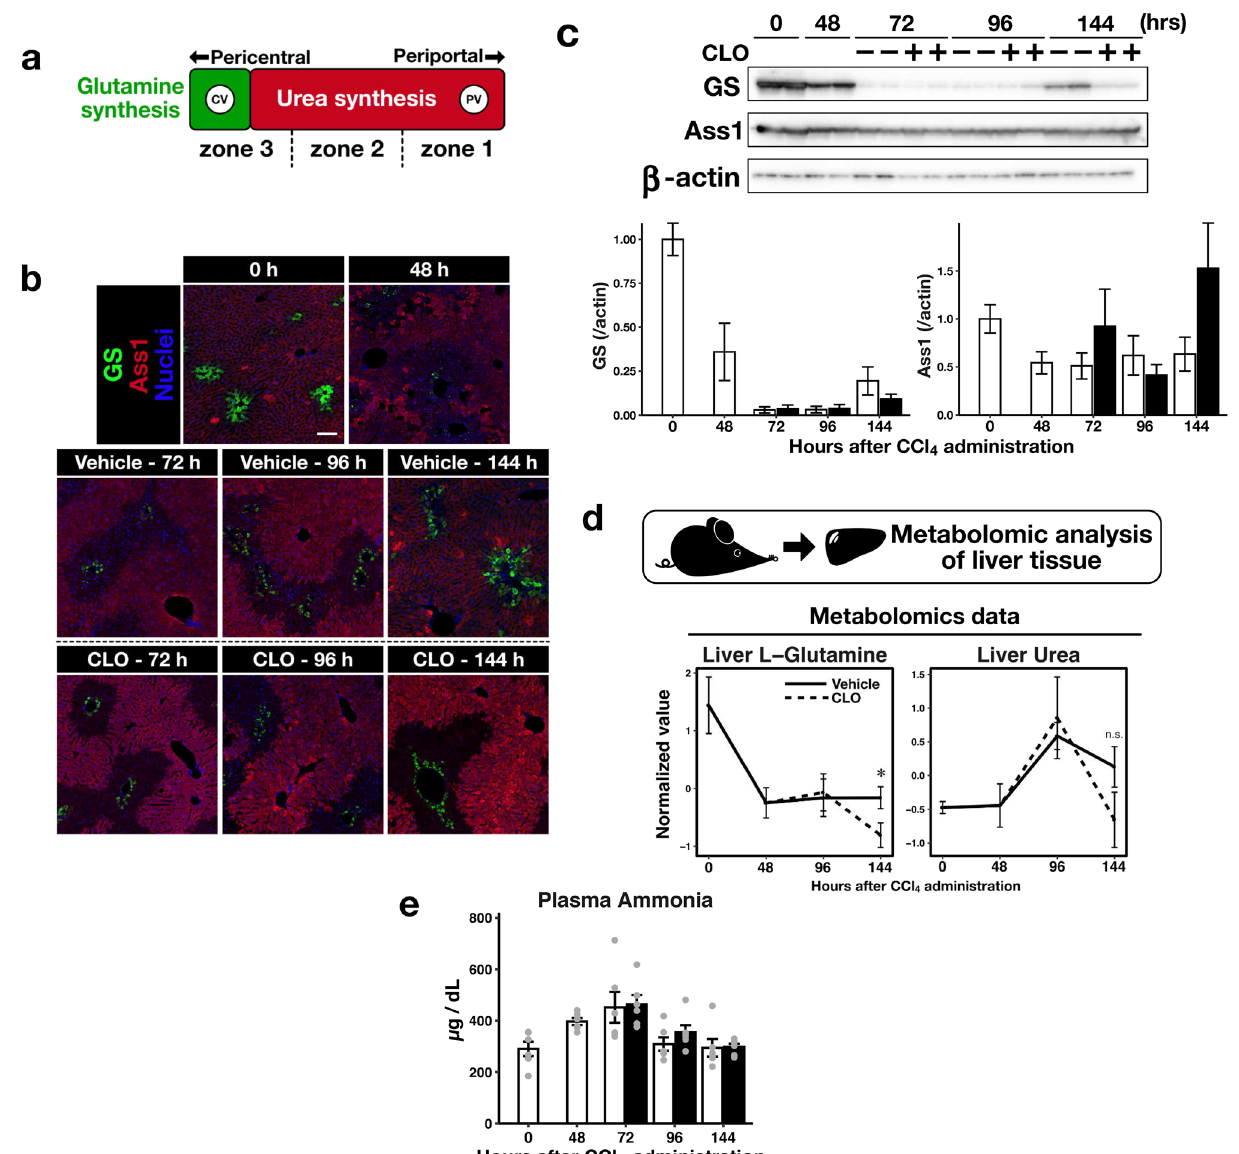
Figure 3. Effects of tissue remodelling suppression on glutamine and urea synthesis during regeneration. ( a ) Zonation patterns of glutamine and urea synthesis in liver lobules. Glutamine was synthesised by hepatocytes surrounding the central veins. Urea was synthesised by all hepatocytes except those surrounding the central vein. CV central vein; PV portal vein. ( b ) Representative immunofluorescence staining images of glutamine synthetase (GS) and argininosuccinate synthase 1 (Ass1) (scale bar, 100 µm); green, GS; red, Ass1; blue, cell nuclei. ( c ) GS and Ass1 protein expression levels measured by immunoblotting. β-actin was used as the loading control. ( d ) Liver glutamine and urea levels revealed by metabolomic analysis. ( e ) Plasma ammonia levels. Data are presented as mean ± SEM (n = 6/group). The vehicle and CLO groups were compared at each time point using Welch’s t -test; *p <